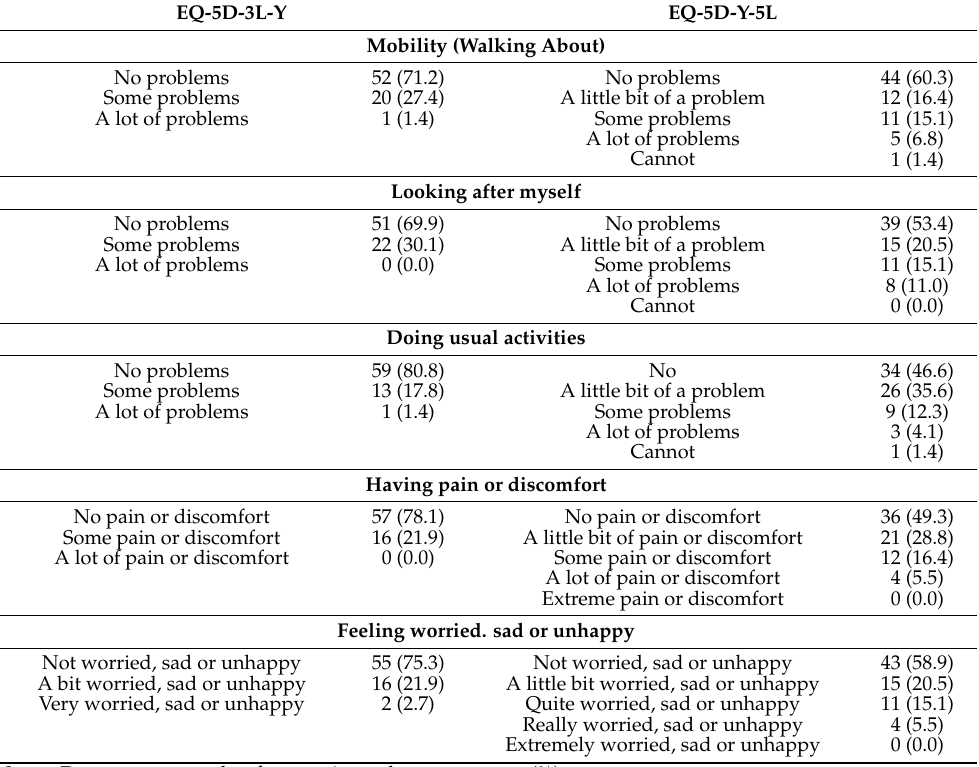
Table 2. Percentages of reported problems in EQ-5D-Y-3L and EQ-5D-Y-5L.